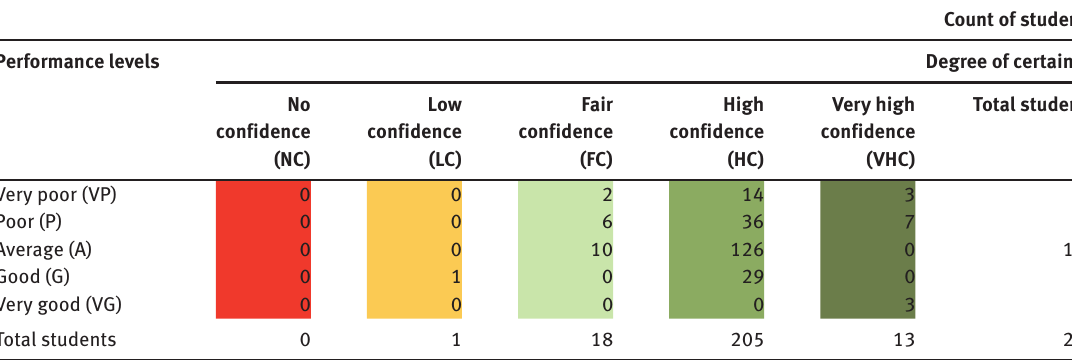
Table 7: Summary of Performance Evaluation of Students in a Multiexpert